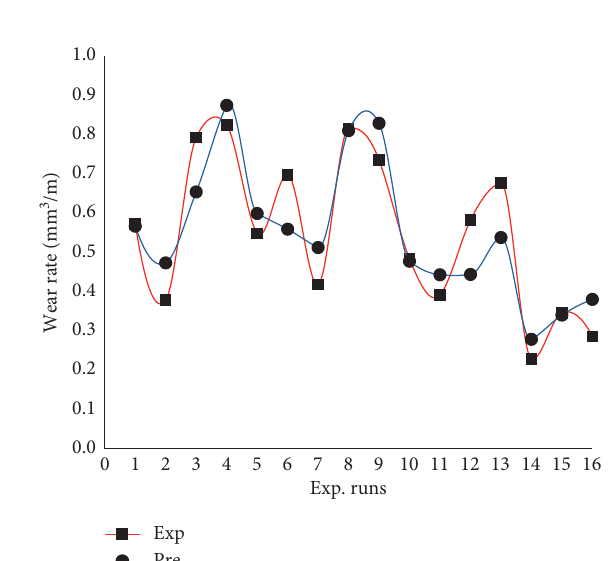
Figure 7: Residual plots for wear rate.